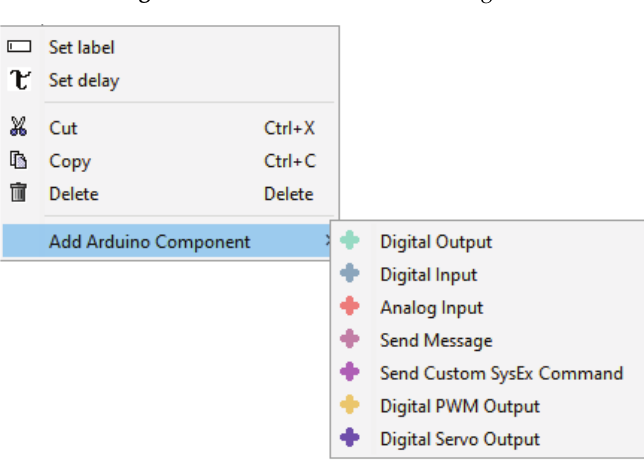
Figure 4. PN2ARDUINO—Class diagram.